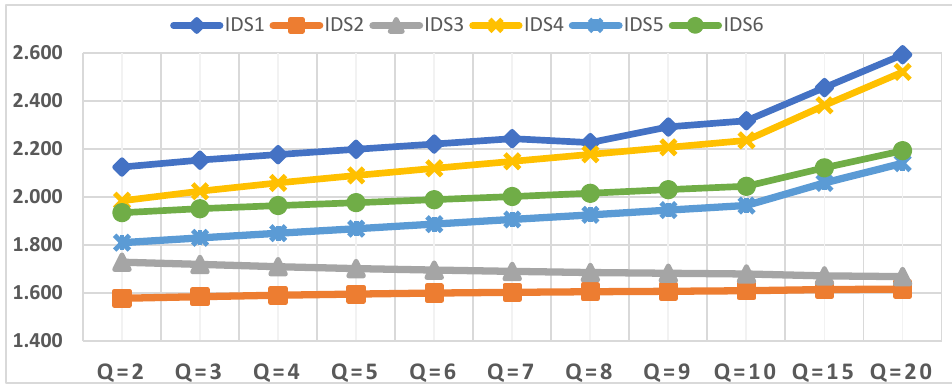
Figure 8. Closeness coefficient values of IDSs in terms of different values of q.